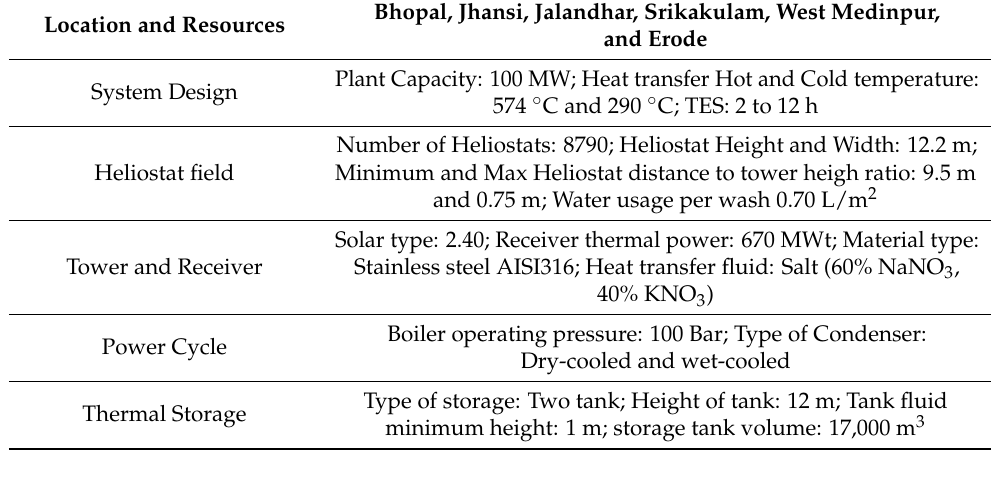
Table A1. Technical parameters used in